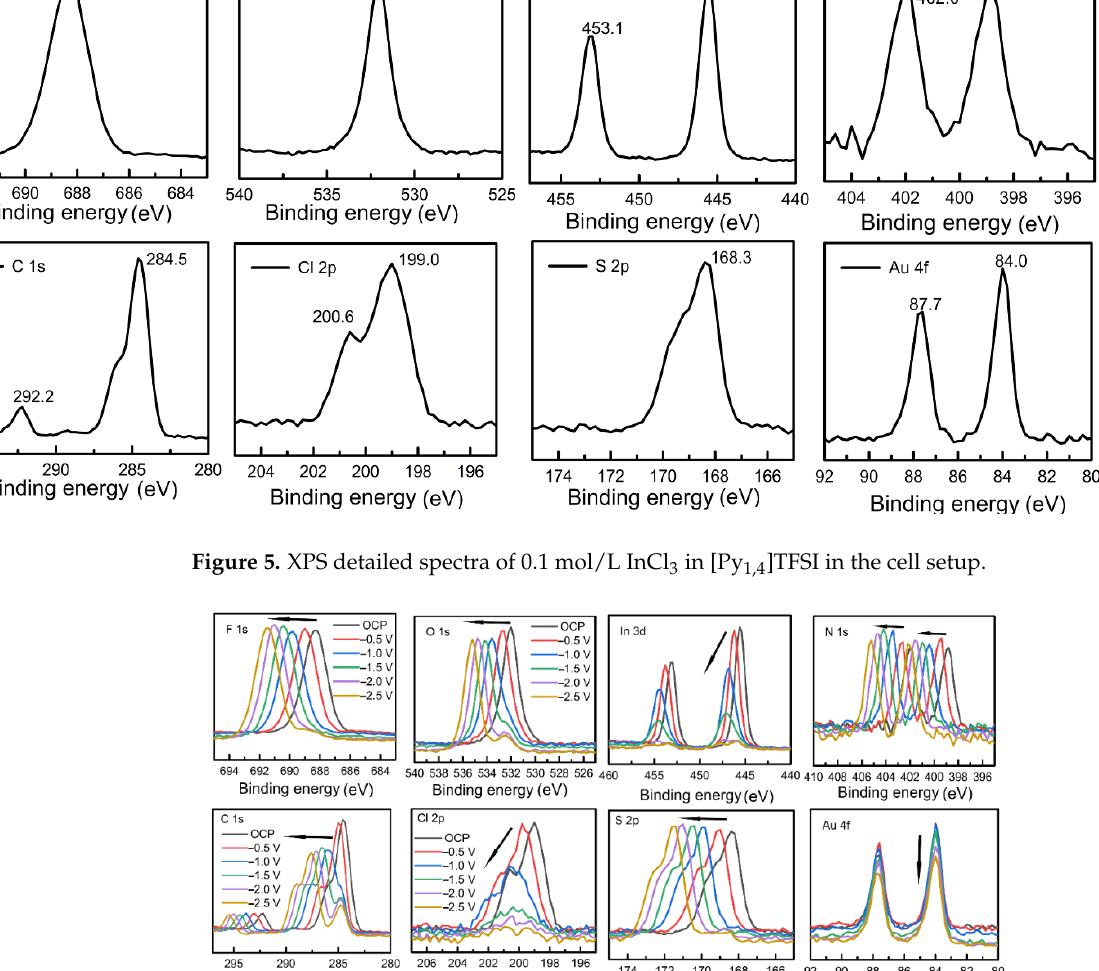
Figure 5. XPS detailed spectra of 0.1 mol/L InCl 3 in [Py 1,4 ]TFSI in the cell setup.